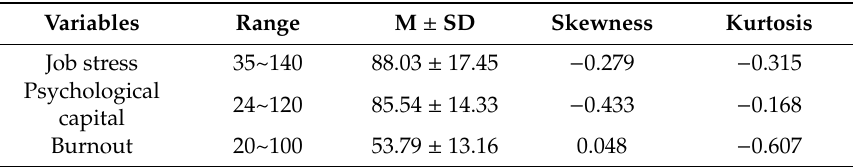
Table 2. Descriptive statistics of research